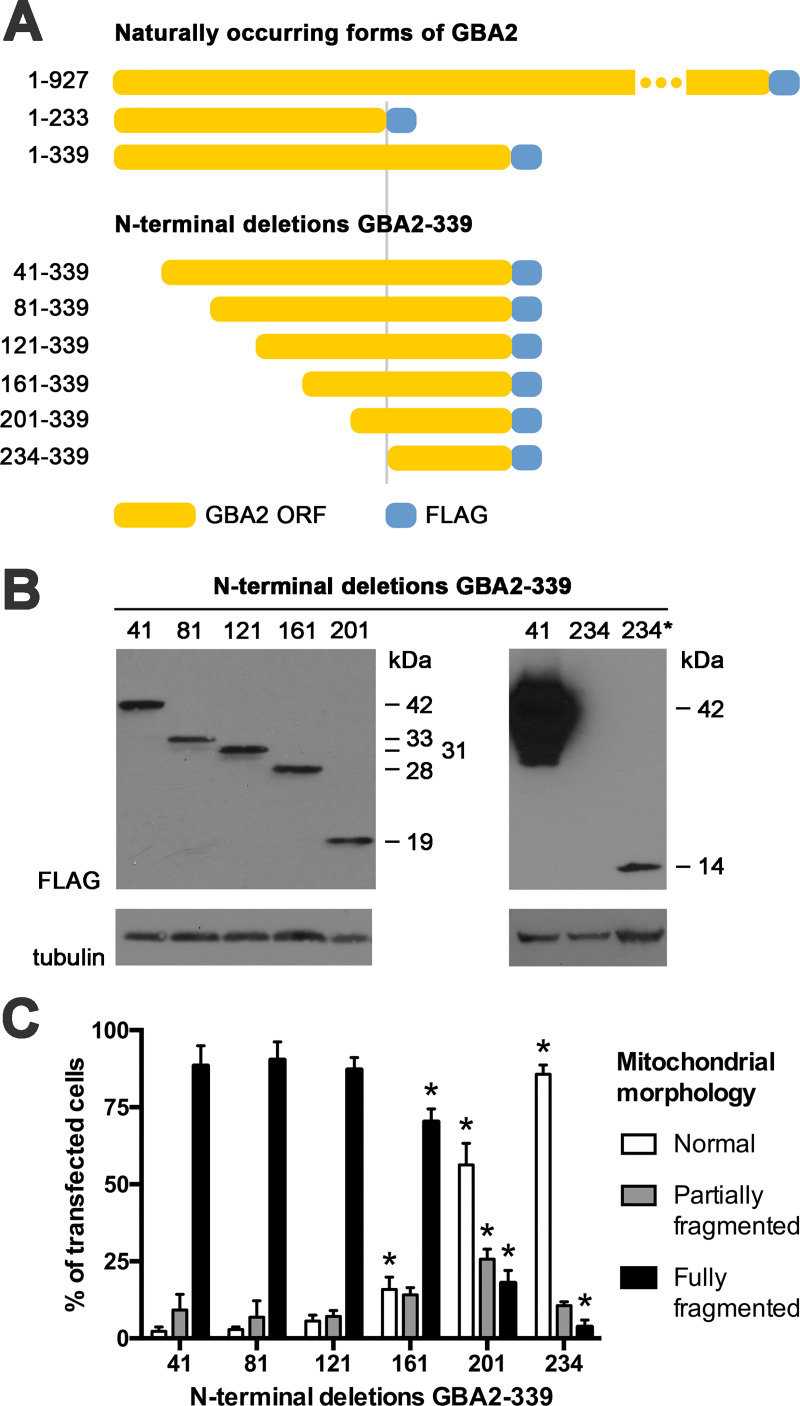
Identification of a mitochondrial targeting domain in GBA2.(A) Schematics of mutant versions of GBA2-339-FLAG carrying increasingly large N-terminal deletions, lacking 40, 80, 120, 160, 200, and 233 amino acids (GBA2[41–339] to GBA2[234–339]); schematics of GBA2-WT, GBA2-233, and GBA2-339 are depicted for reference (schematics drawn to scale, except GBA2-WT). (B) Western blot showing expression of N-terminal deletion mutants depicted in [A] in U2OS cells, “41” indicating GBA2[41–339], etc. Left panel, 8% polyacrylamide gel, 12 μg protein per lane. Right panel, 12.5% polyacrylamide gel; “41” and “234”, 10 μg protein; “234*”, 30 μg protein. Apparent molecular weights are indicated. (C) Distribution of mitochondrial phenotypes in cells expressing different N-terminal deletion mutants of GBA2-339. Data indicate means + SD; at least 250 cells were scored in each of three independent experiments. Asterisk: significantly different compared to cells expressing GBA2[41–339], determined via one-way ANOVA.